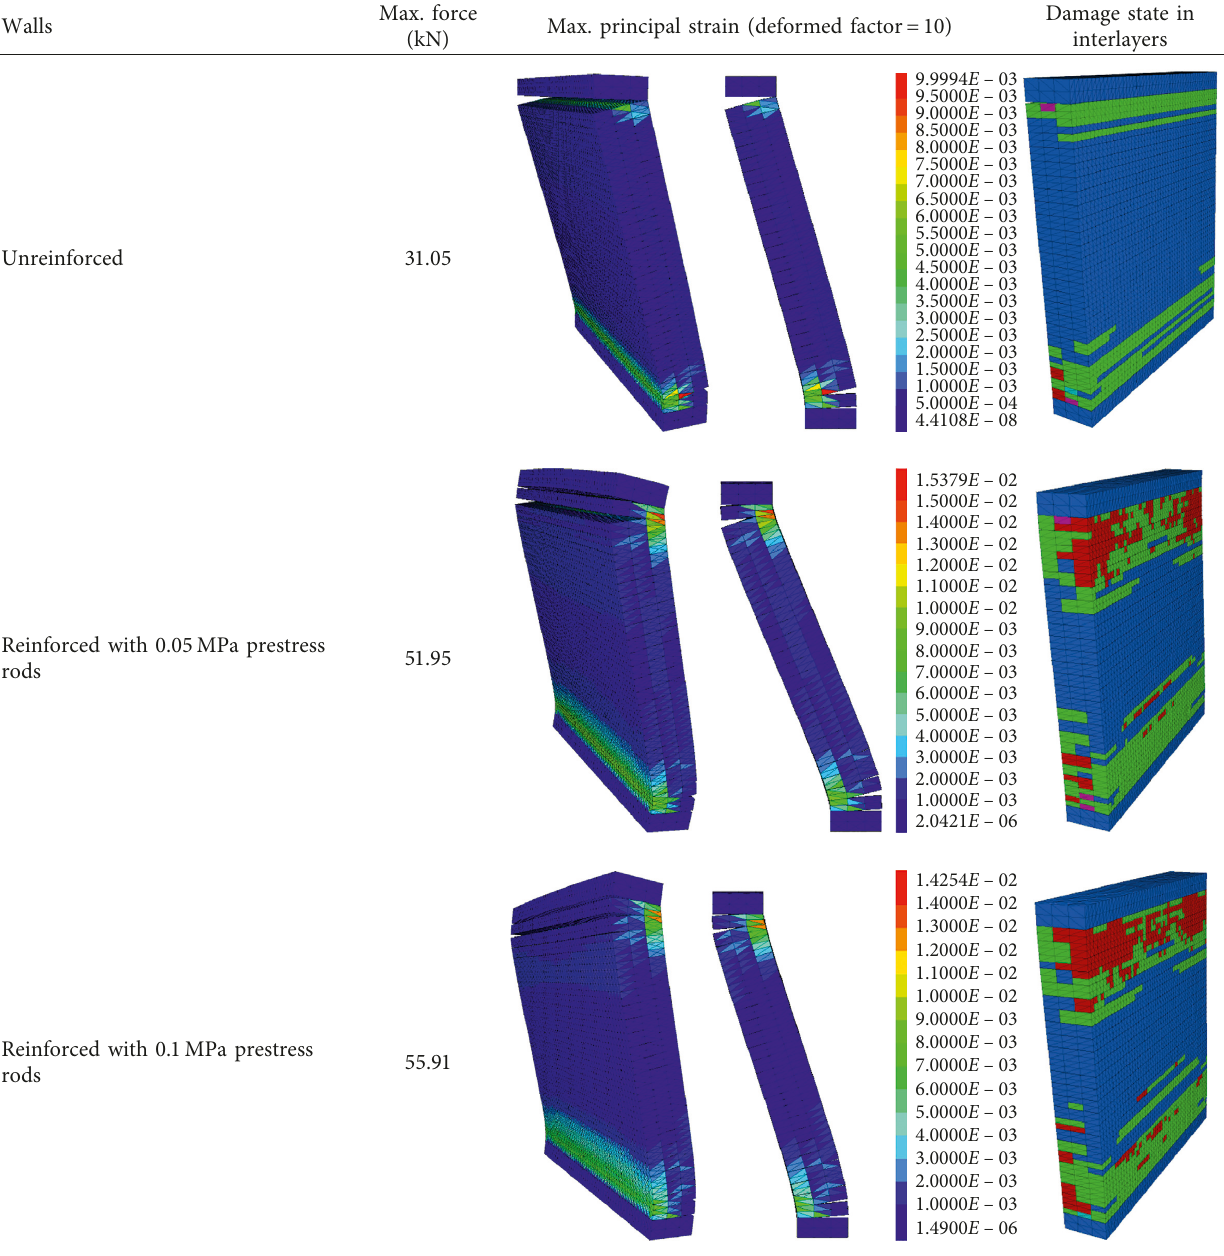
Table 4: Damage evolution in the case of out-of-plane horizontal